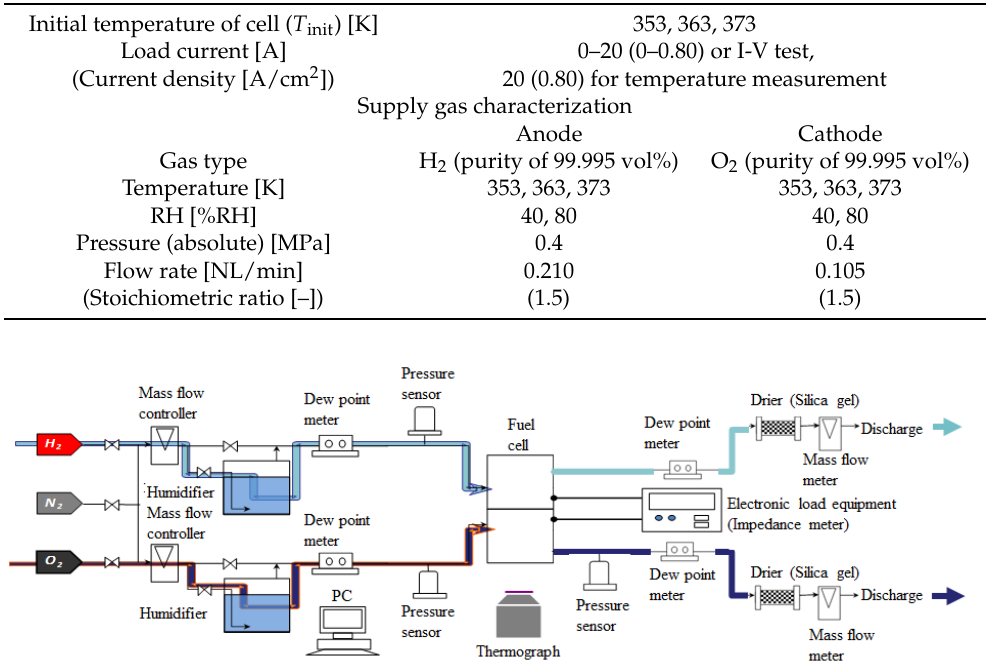
Table 2. Power generation conditions. Although the flow rates of supply gases for the anode and cathode were changed via the stoichiometric ratios of 1.5, 2.0 and 3.0, this study shows the results for a stoichiometric ratio of 1.5.